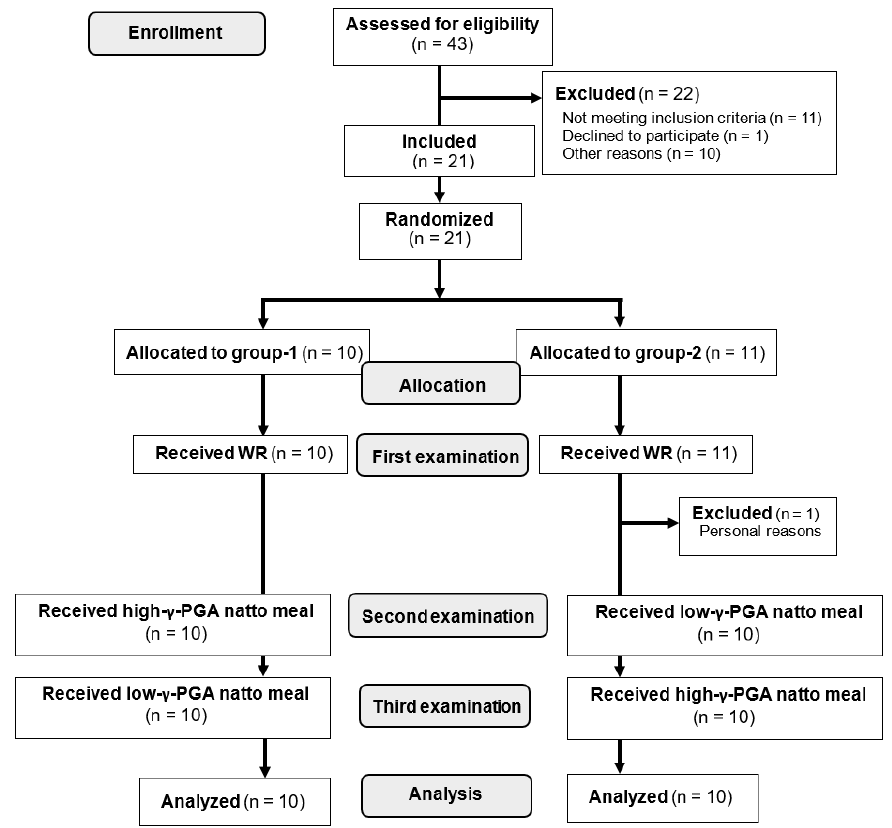
Figure 1. The diagram illustrating the selection of participants for analysis. WR: white rice; γ-PGA: gamma-polyglutamic acid.